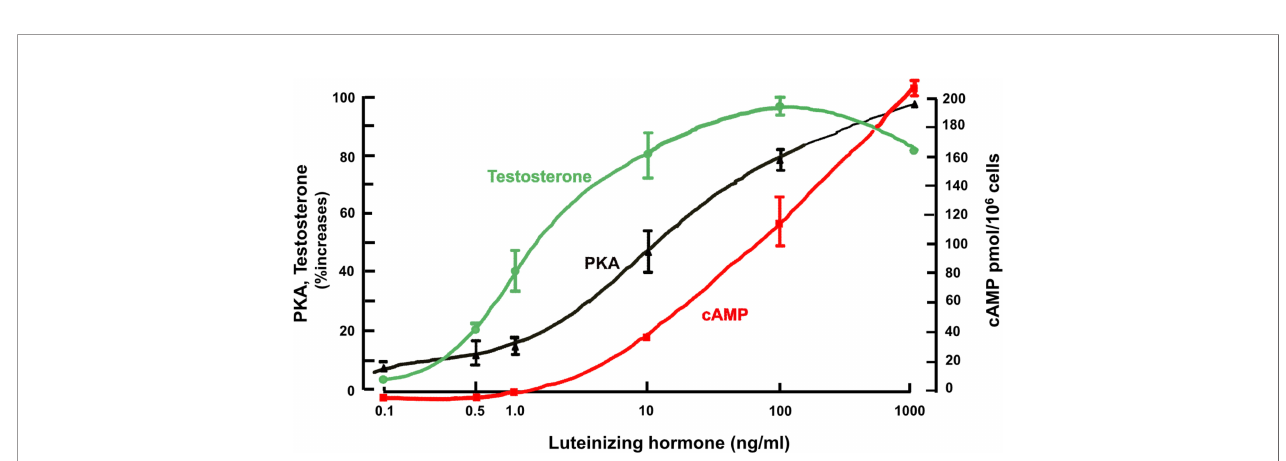
FIGURE 3 | Leydig cells; effect of treatment with luteinizing hormone on PKA activity after 20 mins, cAMP and testosterone after 2 hours (from (49) with